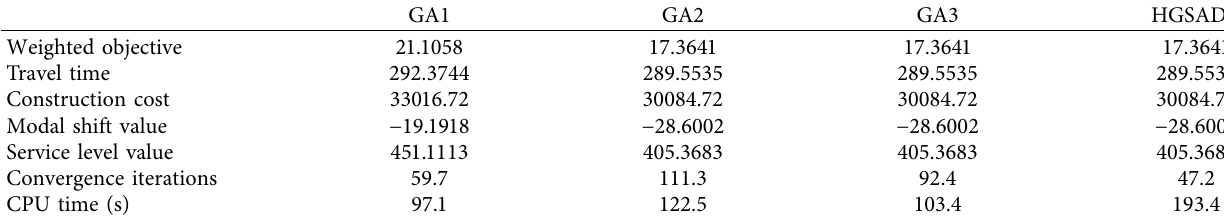
Table 6: Average results of 4 GAs.